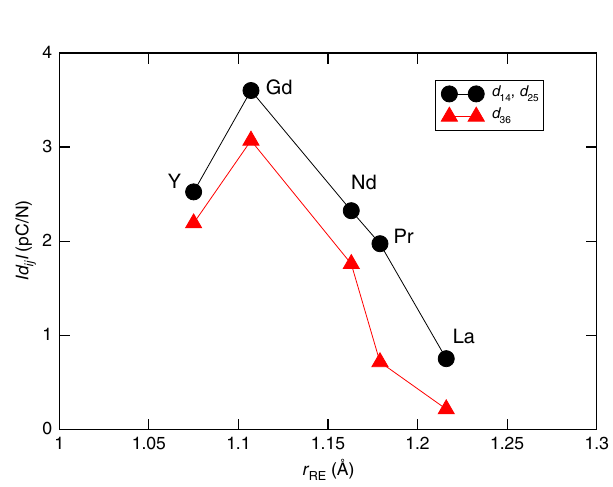
Figure 5 | Calculated piezoelectric coefficients. Piezoelectric strain coefficients ( y axis) for the P (cid:2) 42 1 m Na R SnO 4 structures as a function of the rare-earth cation ionic size in Å, r RE ( x axis). There are three symmetry- allowed d ij components ( d 14 , d 25 and d 36 ) and two of which are equivalent ( d 14 ¼ d 25 ). Table 6 | Total energy difference ( D E in meV per atom) with respect to the lowest energy structure for Na R RuO 4 in two P (cid:2) 42 1 m and Pca 2 1 structures with both FM and AFM spin